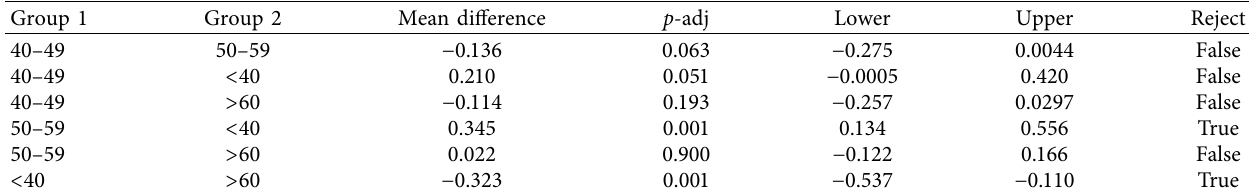
Table 4: Tukey HSD of star rating by age groups, FWER � 0.05.